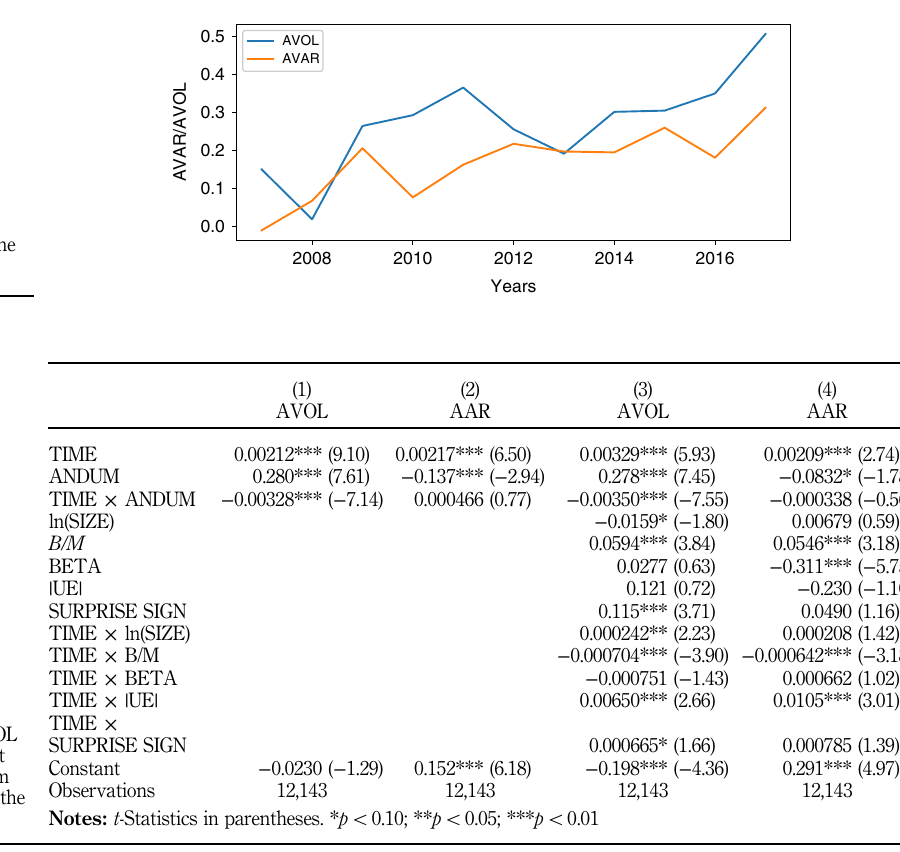
Table II. Regression of AVOL and AVAR against time trend and